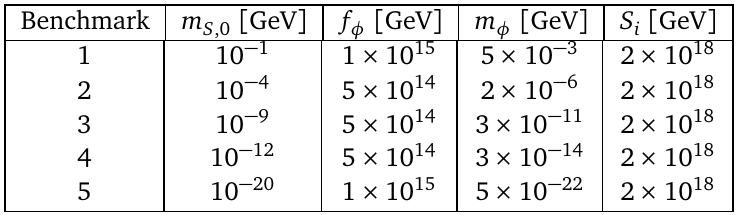
Table 2: The parameters used in order to calculate the spectra shown in Fig. 12.